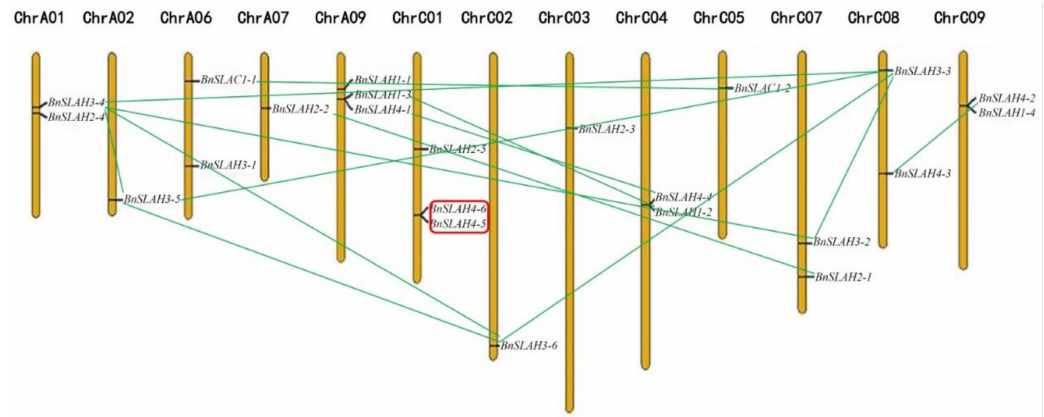
Figure 2. Chromosomal localizations and gene duplication of BnSLAC / SLAH genes. Tandem duplication genes were circled with red line, and segmental duplication were linked with green